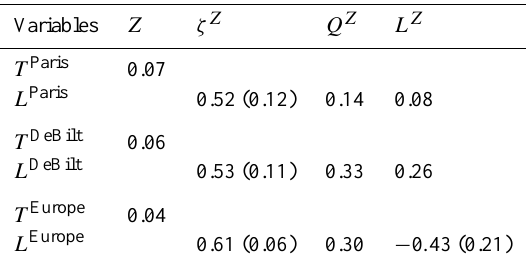
Table 1. Correlations between ζ 2 , Q 2 and L 2 transforms of daily temperature series and the Z component of the geomagnetic field, between 1940 and 2009 ( 2 = 11 × 365). p-values for n = 10 de- grees of freedom are indicated in parentheses when the correlation coefficient exceeds 0.4. Correlations under 0.4 are not considered